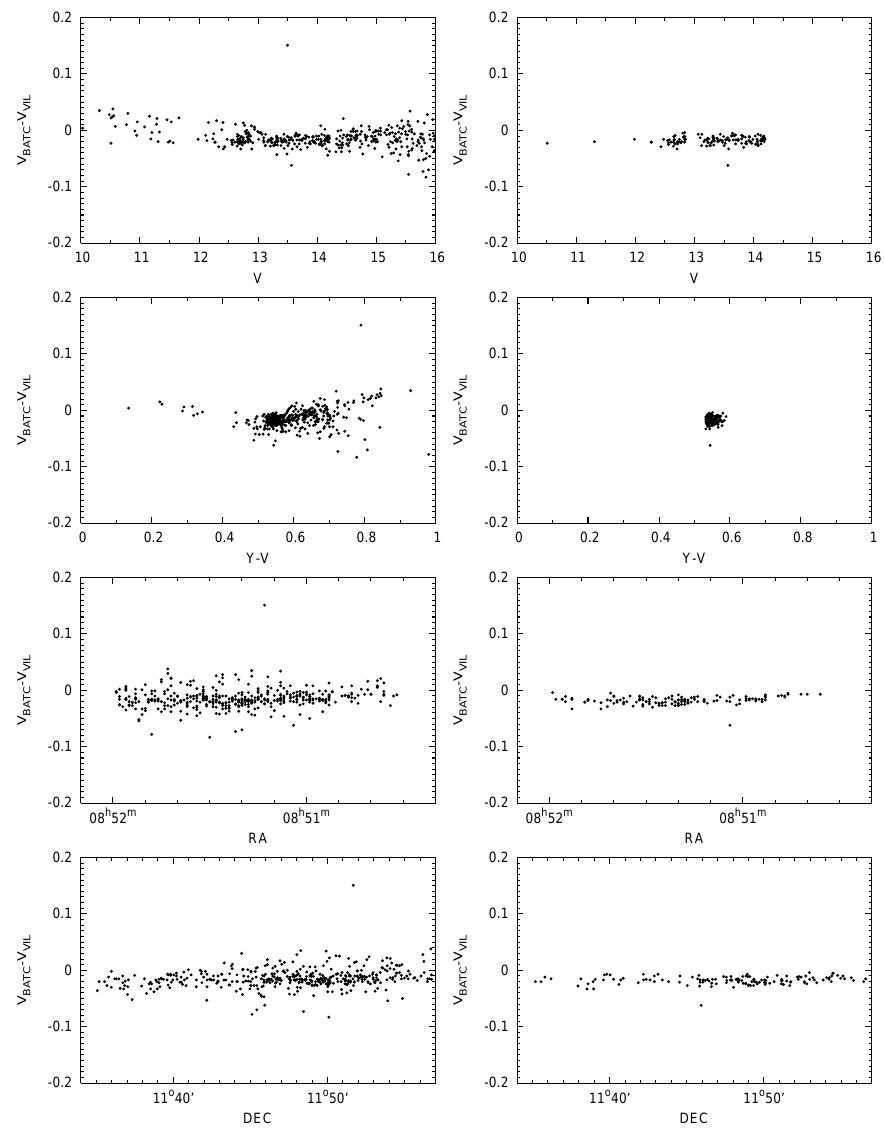
Fig. 1. Differences between the V BATC and V VIL magnitudes. Left panels show all 412 stars in common, and right panels are only for the stars brighter than 14.2 mag in V and within the narrow color interval: 0 . 53 < Y − V < 0 . 59 . Large-scale differences between these photometries are within ±